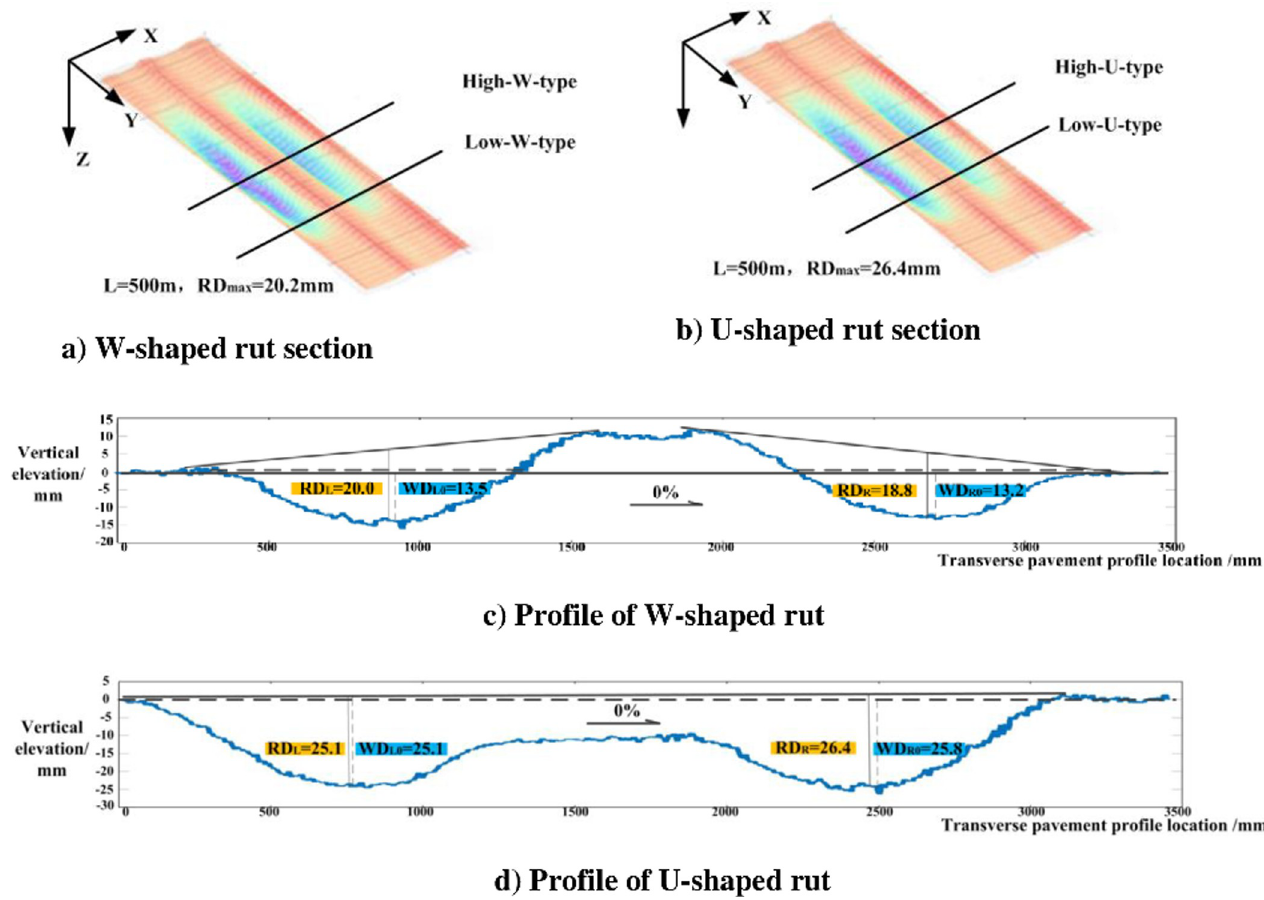
Fig 6. Characteristic profile of